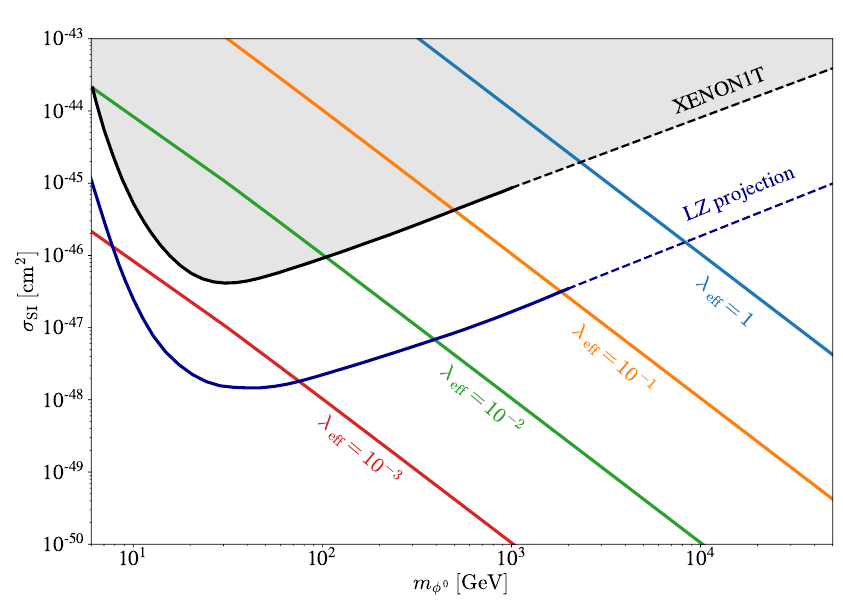
Figure 3: Spin-independent cross section for various values of λ current bounds from XENON1T (black) and the projected future sensitivity from LZ (violet) are also